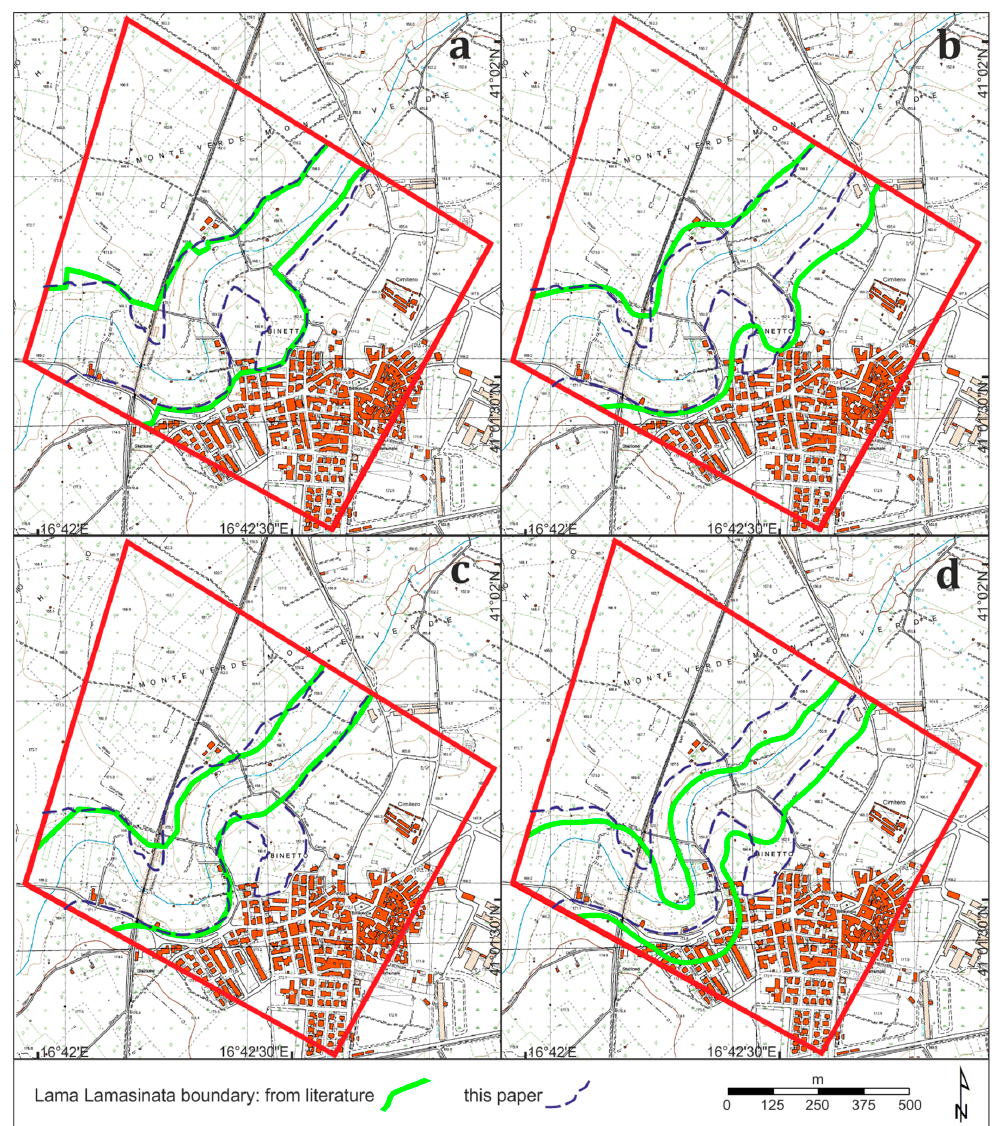
Figure 11. Lama Lamasinata has been mapped over the years in different regional works, here its boundary has been drawn over the official regional technical base map of the Apulia region (CTR) as shown in: ( a ) geomorphological map included in the Apulian Territorial-Landscape Regional Plan (PPTR) (Apulia Region, 2015); ( b ) hydro-geomorphological map of the Apulia region (http://93.51.158.165/geomorfologica/map_default.phtml); ( c ) map extracted from the study for defining the needed hydraulic work in catchment basins of the Bari and Brindisi provinces which suffered catastrophic flood events in October and November 2005 (Basin Authority of Apulia region 2012) and ( d ) geomorphological map showing fluvial landforms in relation to the geological setting in the “Murge Basse” karst of Apulia (Bari Metropolitan Area, Southern Italy) [17]. Blue lines represent the Lama Lamasinata boundary as shown in this study. This difference in the cartographic representation of the same landform may be related to several aspects, among which the final purpose of the maps, the different scale of representations, and the approaches followed for mapping this landform are the main reasons to explain the observed